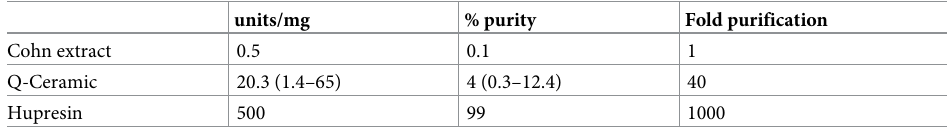
Table 3. Purity of HuBChE after chromatography on Q-Ceramic and